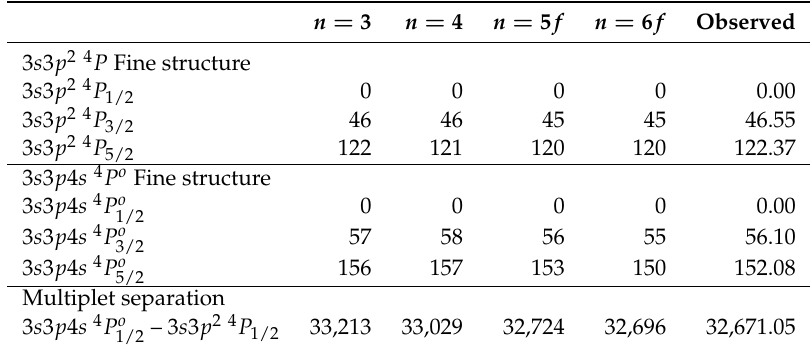
Table 1. Convergence of the energy level structure for a valence correlation calculation is compared with observed data [4,7]. All results are in cm − 1 .